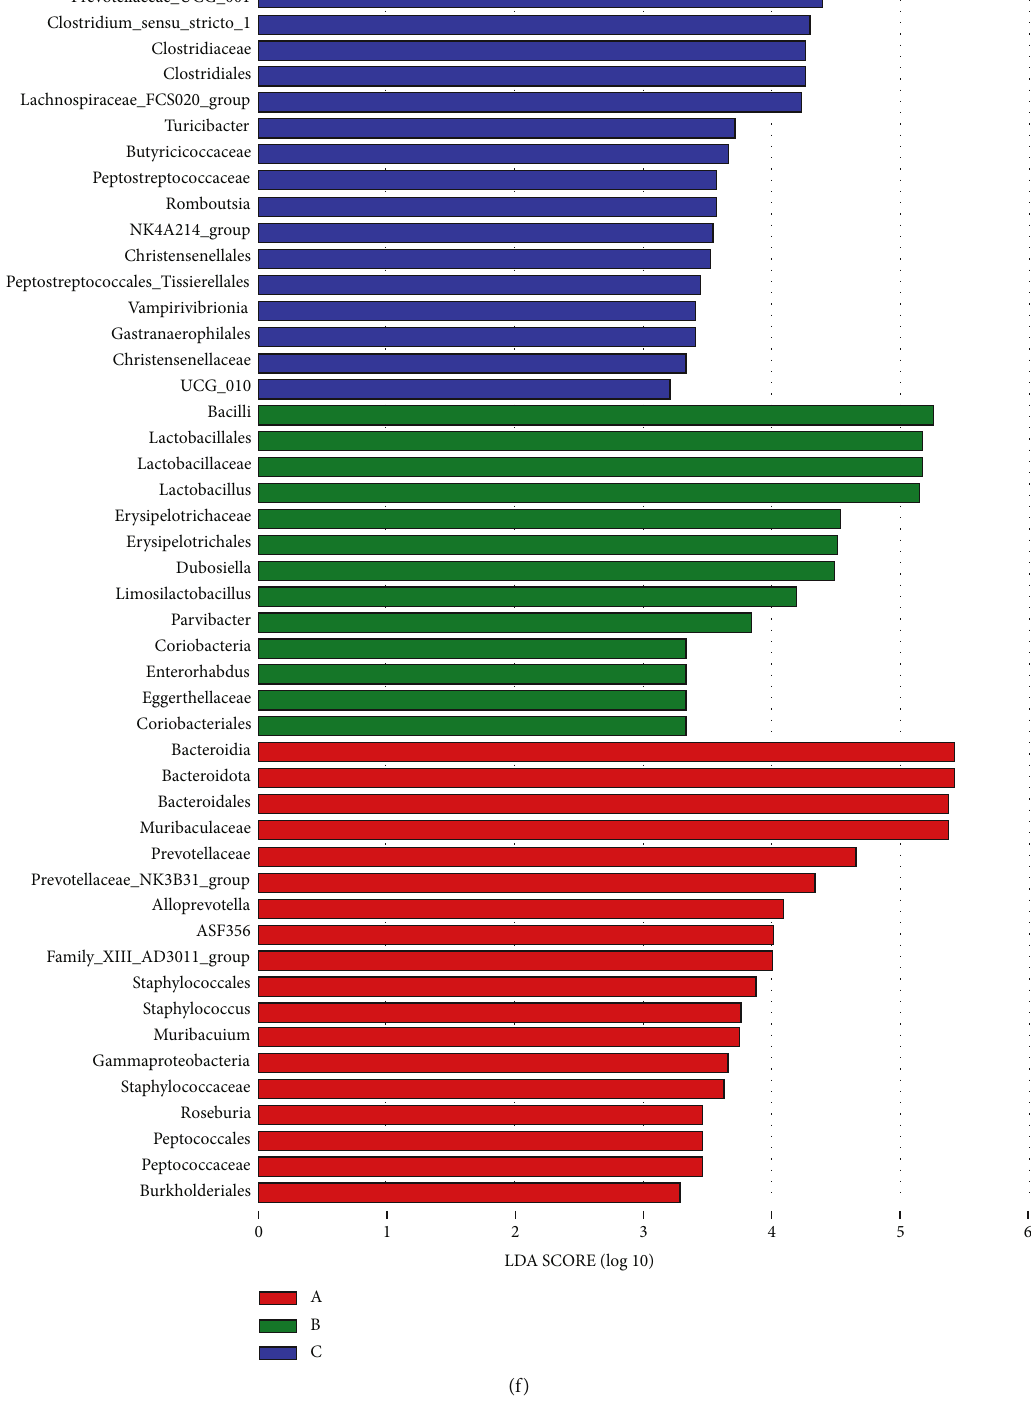
Figure 3: E ff ect of Qinghua Jianpi Recipe on the intestinal micro fl ora structure of colorectal adenoma canceration model mice. (a) Rarefaction curve, the depth of sample sequencing can be obtained by making dilution curve; (b) alpha-diversity, the abundance and diversity of microbial communities can be re fl ected by single-sample diversity analysis (alpha diversity), including Simpson, Shannon, and Chao indexes; (c) beta diversity analysis, used to study similarities or di ff erences in the composition of sample communities; (d, e) diversity analysis of intestinal microbiota of rats in each group; (F) LEfSe analysis, the fi gure shows the LDA scores obtained by LDA (linear regression analysis) for the microorganisms with signi fi cant e ff ects in the two